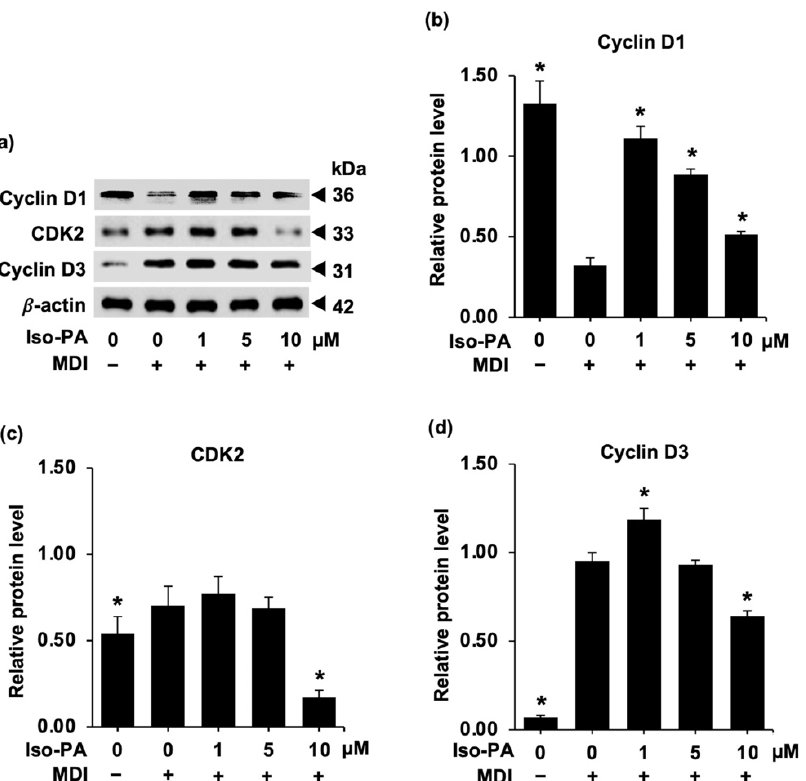
Figure 4. Isopanduratin A alters cell-cycle-regulating proteins during differentiation of 3T3-L1 adipocytes. The band intensity of the target protein obtained from ( a ) Western blot analysis was estimated by comparison with that of β -actin (internal reference) including ( b ) cyclin D1, ( c ) CDK 2, and ( d ) cyclin D3. Confluent 3T3-L1 cells were cultured in the presence (+) or absence ( − ) of differentiation medium (MDI) with 0–10 μ M isopanduratin A (Iso-PA). Cells treated with 0.5% v / v DMSO functioned as untreated control (0). Bar graphs demonstrating mean ± SD (n = 3) were created using GraphPad Prism. A one-way ANOVA with Tukey’s post hoc test was used to compare the means of treatment and differentiated control groups (* p < 0.05) .